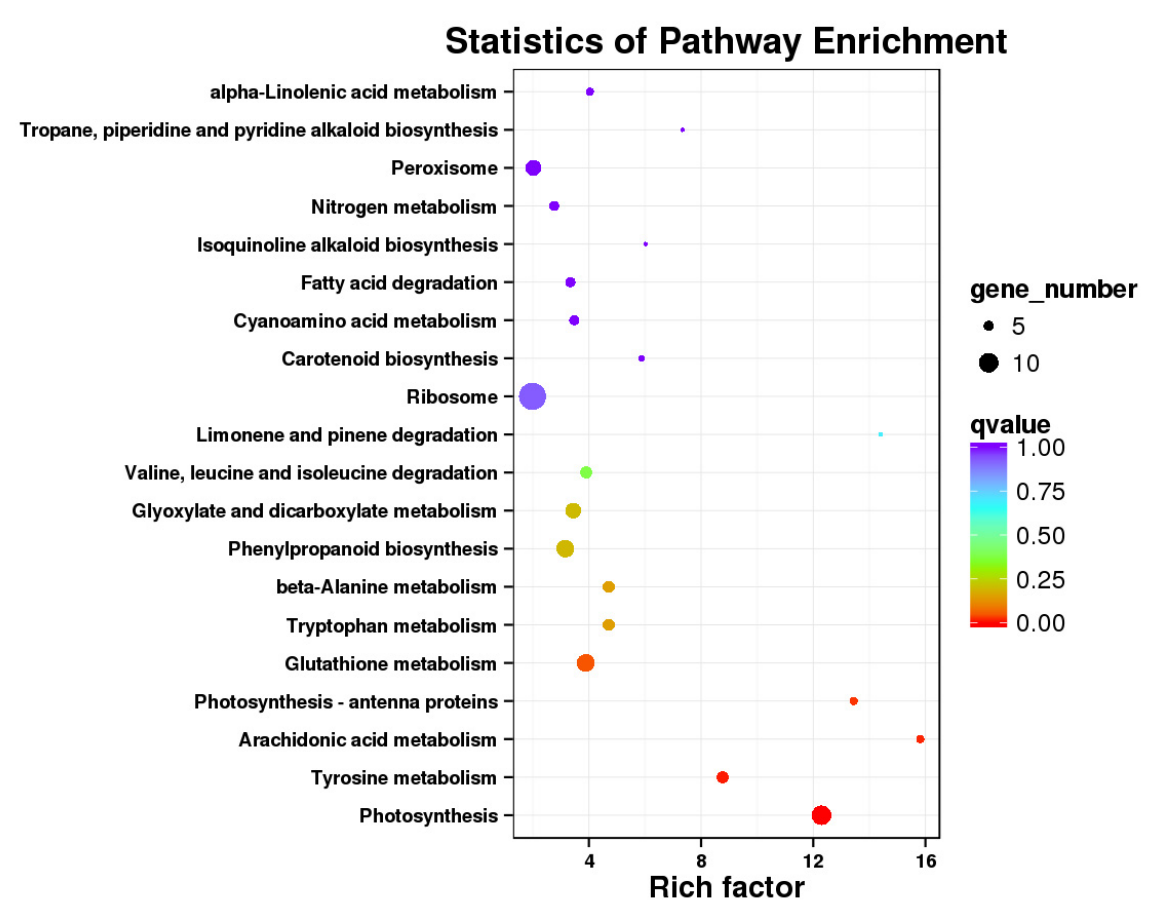
Figure 3. Scatterplot of KEGG pathway enrichment of DETs in leaves. Each circle in the figure represents a KEGG pathway; the Y-axis presents the name of the pathway; and the X-axis presents the enrichment factor, indicating the ratio of the proportion of transcripts in the DETs that are annotated to the pathway to the proportion of transcripts in all transcripts that are annotated to the pathway. The higher the enrichment factor, the more significant the enrichment level of the DETs is in this pathway. The color of the circle represents the q-value; the q-value is the p -value after multiple hypothesis tests and corrections. The smaller the q ‐ value is, the more reliable the enrichment significance of the DETs in this pathway. The size of the circle indicates the number of transcripts enriched in the pathway; the larger the circle, the more transcripts.